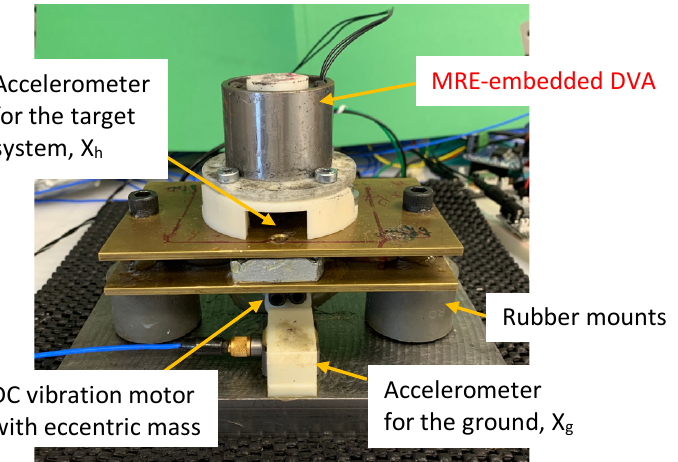
Figure 9. Testing setup for frequency response measurement of the target system with the MRE-embedded DVA.